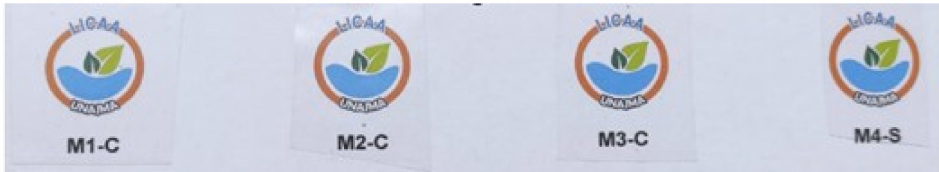
Figure 5. Transparency of films on